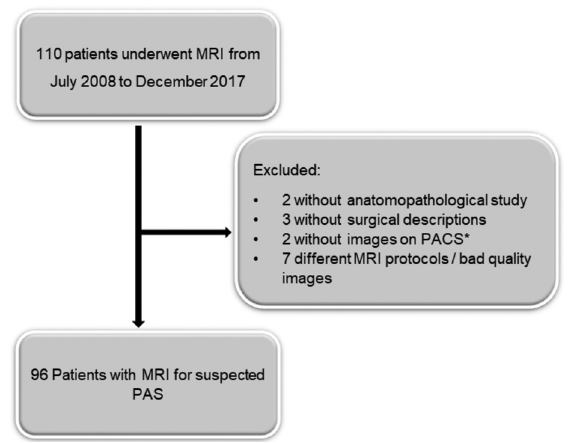
Fig. 1. Flowchart of the study population. *PACS (Picture Archiving and Com- munication System).